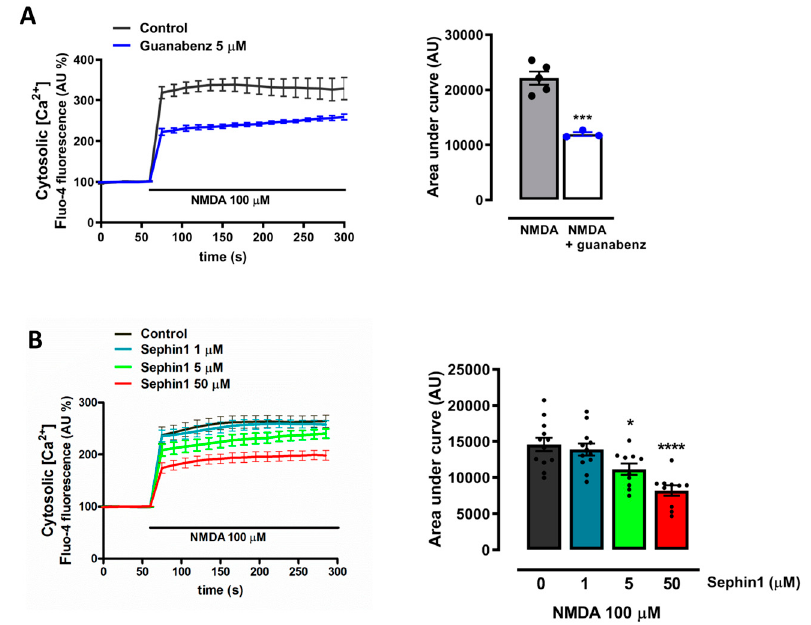
Figure 4. Sephin1 and guanabenz reduce NMDA-induced cytosolic Ca 2 + load. ( A ) Fluo-4-loaded neurons were exposed to NMDA (100 µ M) in the absence or presence of guanabenz (5 µ M) and cytosolic Ca 2 + load quantified. *** p < 0.001 compared to control cells (NMDA alone), unpaired Student’s t-test. ( B ) Neurons were treated in the absence or presence of Sephin1 (1, 5 and 50 µ M) and cytosolic Ca 2 + load quantified. * p < 0.05, **** p < 0.0001 compared with control (NMDA alone), one-way ANOVA followed by Bonferroni´s post hoc test. Traces show normalized means ± SEM of several fields of view ( n ) from no less than three independent cultures. Statistical significance was calculated from normalized average ± SEM of the area under the curve.